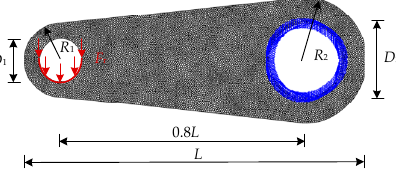
Figure 17. Design domain and boundary conditions for a curved plate with circular holes.